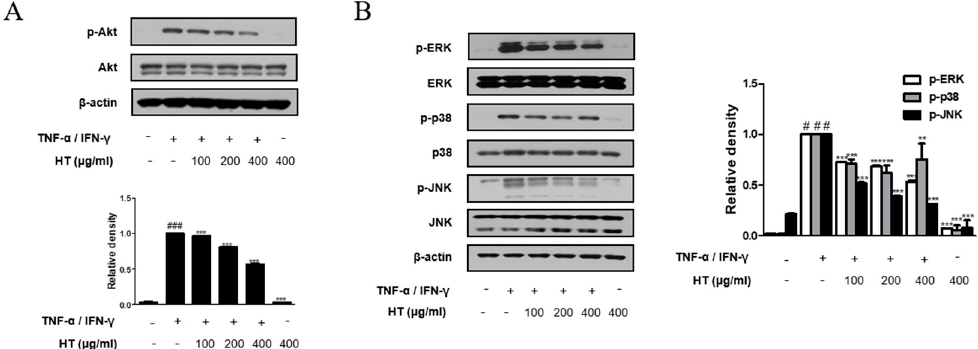
Figure 6. Effect of HT on the phosphorylation Akt and MAPK in TNF- α /IFN- γ -stimulated HaCaT keratinocytes. HaCaT keratinocytes were pre-treated with HT for 1 h and then stimulated with TNF- α /IFN- γ (10 ng/mL) for 5 min. Total proteins were prepared and western blotted for ( A ) Akt and ( B ) MAPK family using specific antibodies. β -actin was used as internal control. The data shown represent mean ± S.D. of three independent experiments. # p < 0.05, ### p < 0.001 vs. the control group; ** p < 0.01, and *** p < 0.001 vs. TNF- α /IFN- γ -stimulated group.